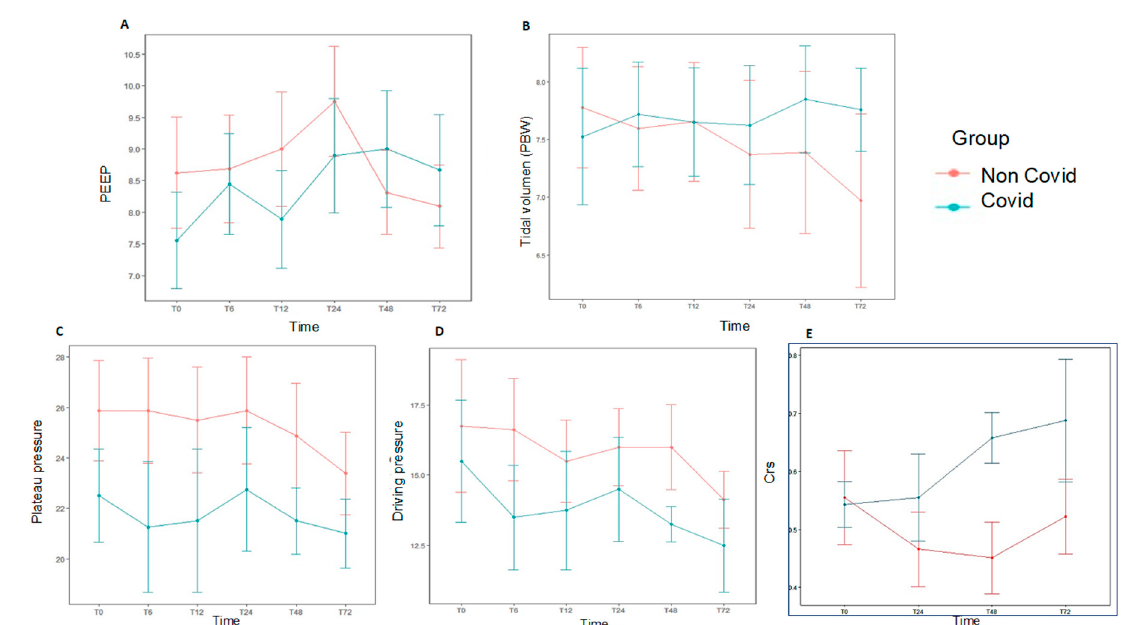
Figure 3. Daily ventilation data at different time points over the first 72 h for each study group, subjects diagnosed with AHRF and COVID-19 ( n = 9) compared with those with AHRF without COVID-19 ( n = 19). There was no statistical significance in the data shown. ( A ). PEEP. ( B ). Tidal volume accorfing to PBW. ( C ). Plateau pressure. ( D ). Driving pressure. ( E ). Static respiratory compliance (Crs). AHRF: Acute Hypoxemic Respiratory Failure. Crs: static respiratory compliance; PBW: predicted body